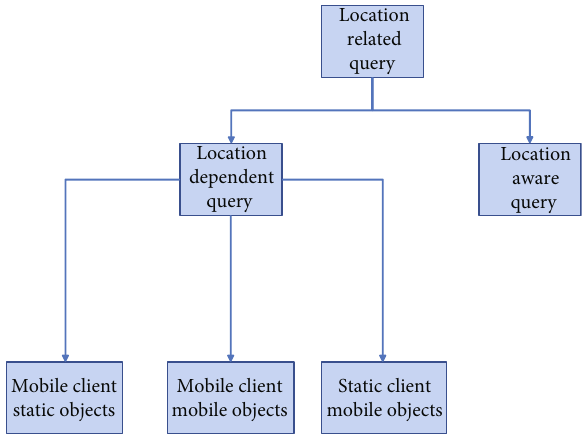
Figure 1: Classi fi cation of location-related